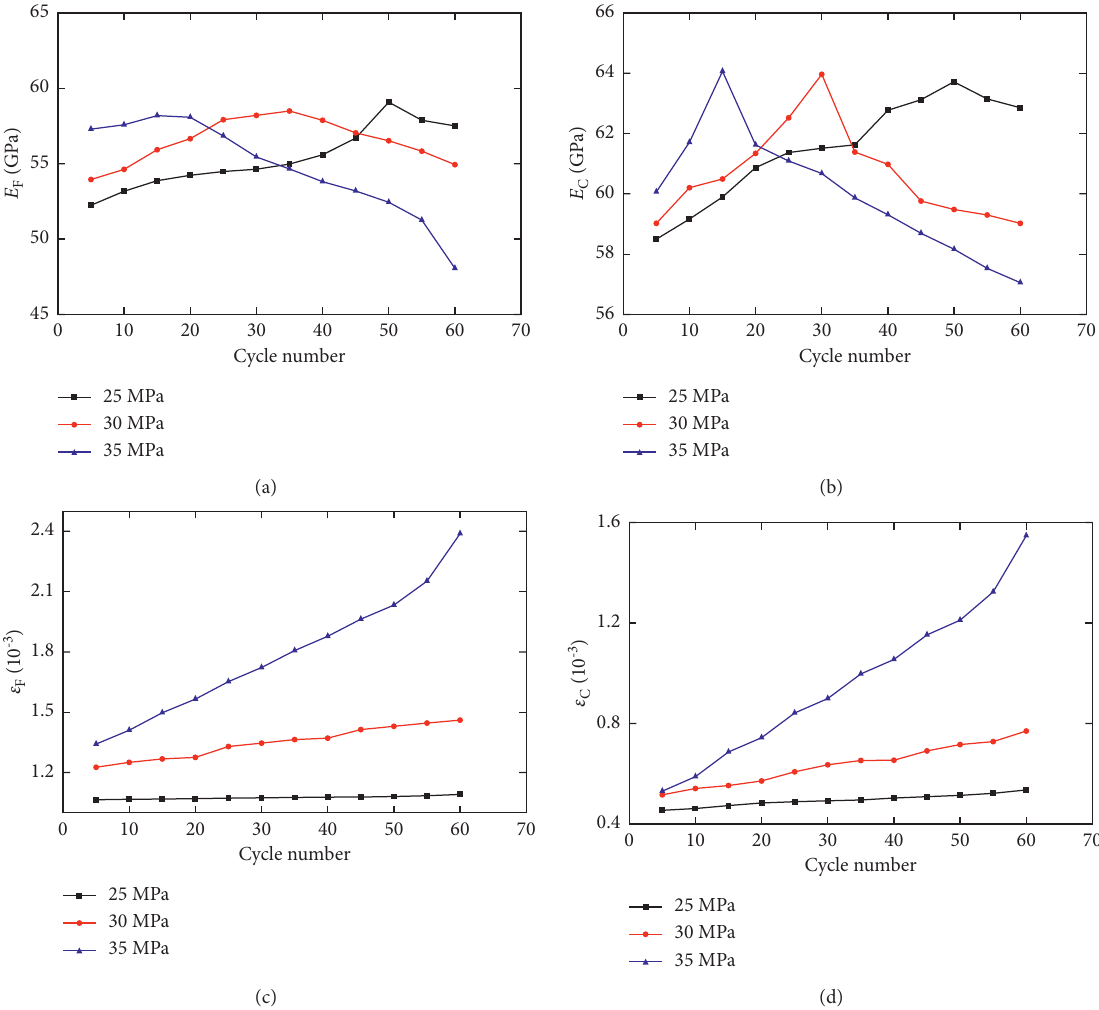
Figure 5: Variation law of mechanical properties of concrete under different stress amplitudes. (a) Variation law of loading elastic modulus E F of concrete with the cycle number C under different stress amplitudes. (b) Variation law of unloading elastic modulus E C of concrete with the cycle number C under different stress amplitudes. (c) Variation law of peak strain ε F of concrete with the cycle number C under different stress amplitudes. (d) Variation law of residual plastic deformation ε C of concrete with the cycle number C under different stress